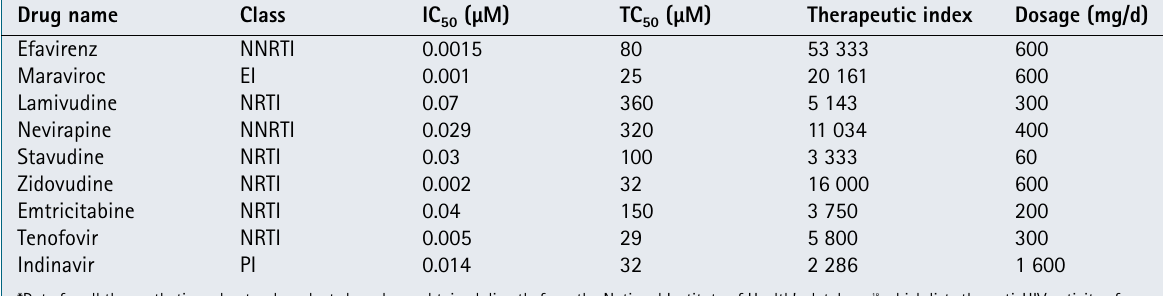
TABLE II. ANTIRETROVIRAL ACTIVITY AND ACTUAL DOSAGE OF SEVERAL SYNTHETIC PRODUCTS*